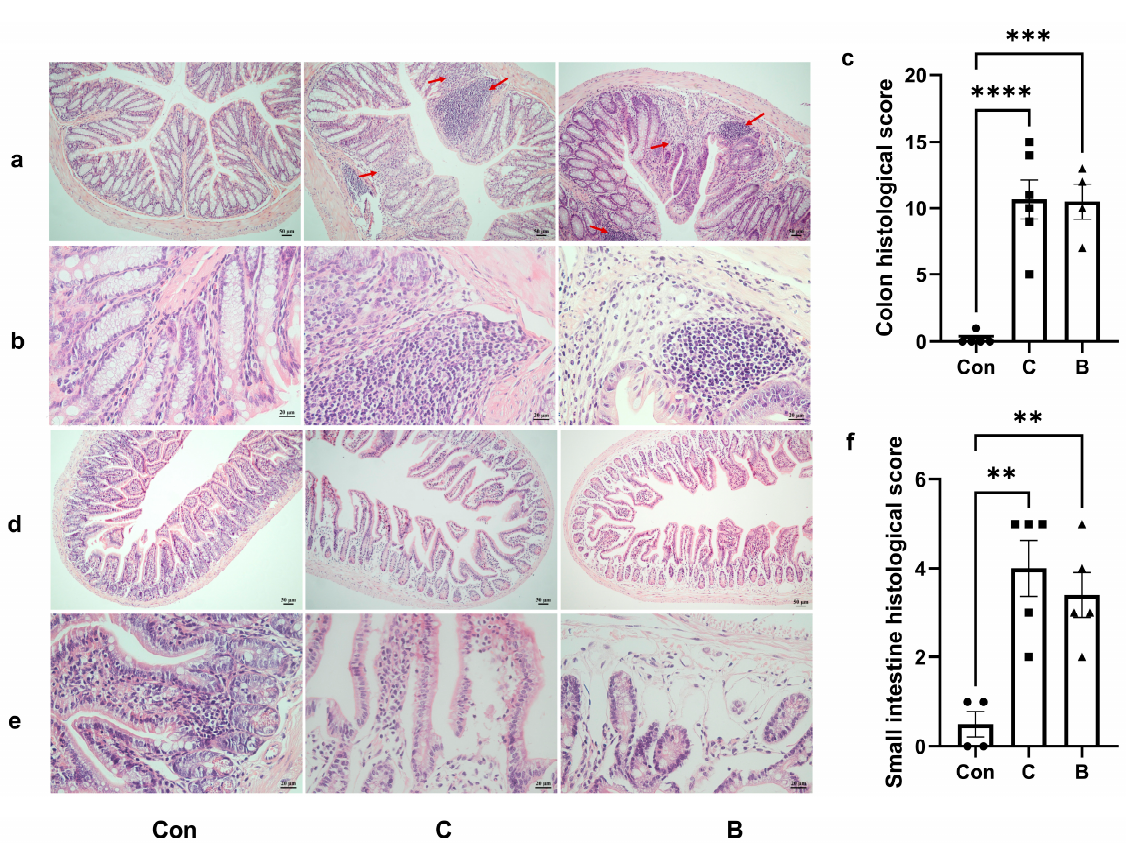
Figure 5. Group with long-term administration of DSS (group C) and group with 7-day administration of 3% DSS (group B) exhibit similar intestinal pathology. ( a ) HE colon staining (100× magnification) ; ( b ) HE colon staining (400× magnification ); ( c ) histological score of colonic tissue; ( d ) HE small intestine staining (100× magnification) ; ( e ) HE small intestine staining (400× magnification) ; ( f ) hist o- logical score of small intestinal tissue. The value of the histological score was shown as the mean ± SEM for 5–8 animals per group. ● represents the individual in group con, ■ represents the indi- vidual in group C, ▲ represents the individual in group B, , ** p < 0.01; *** p < 0.001; **** p < 0.0001.